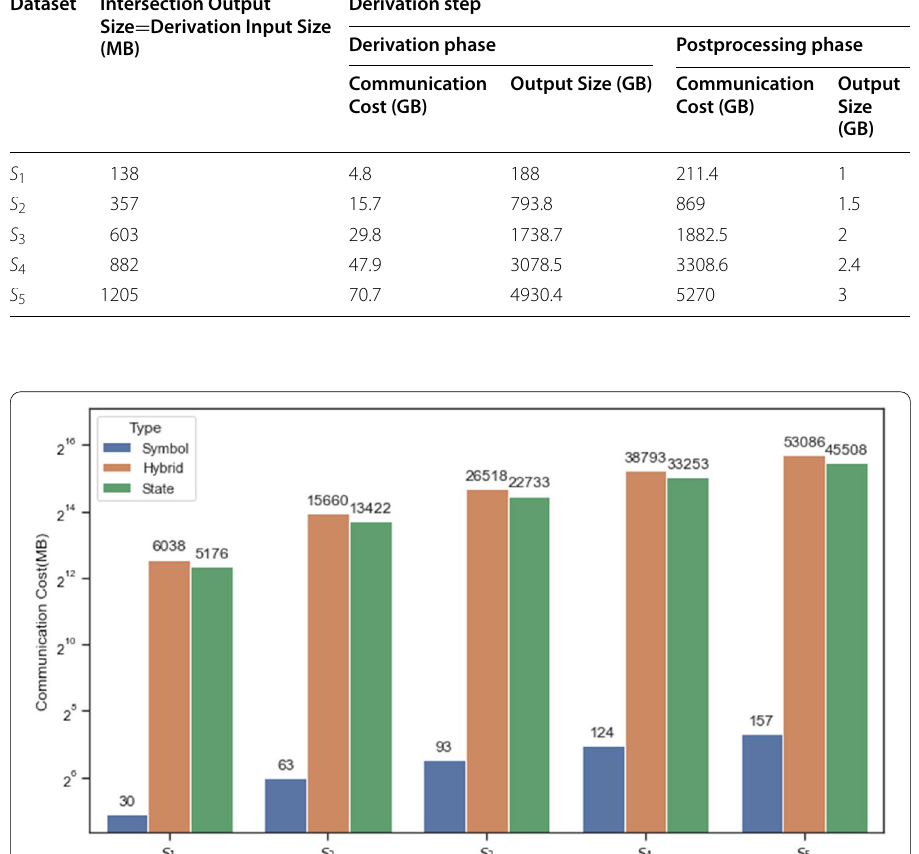
Table 2 The communication cost of the intersection step and the derivation step for some datasets Dataset Intersection Output Size